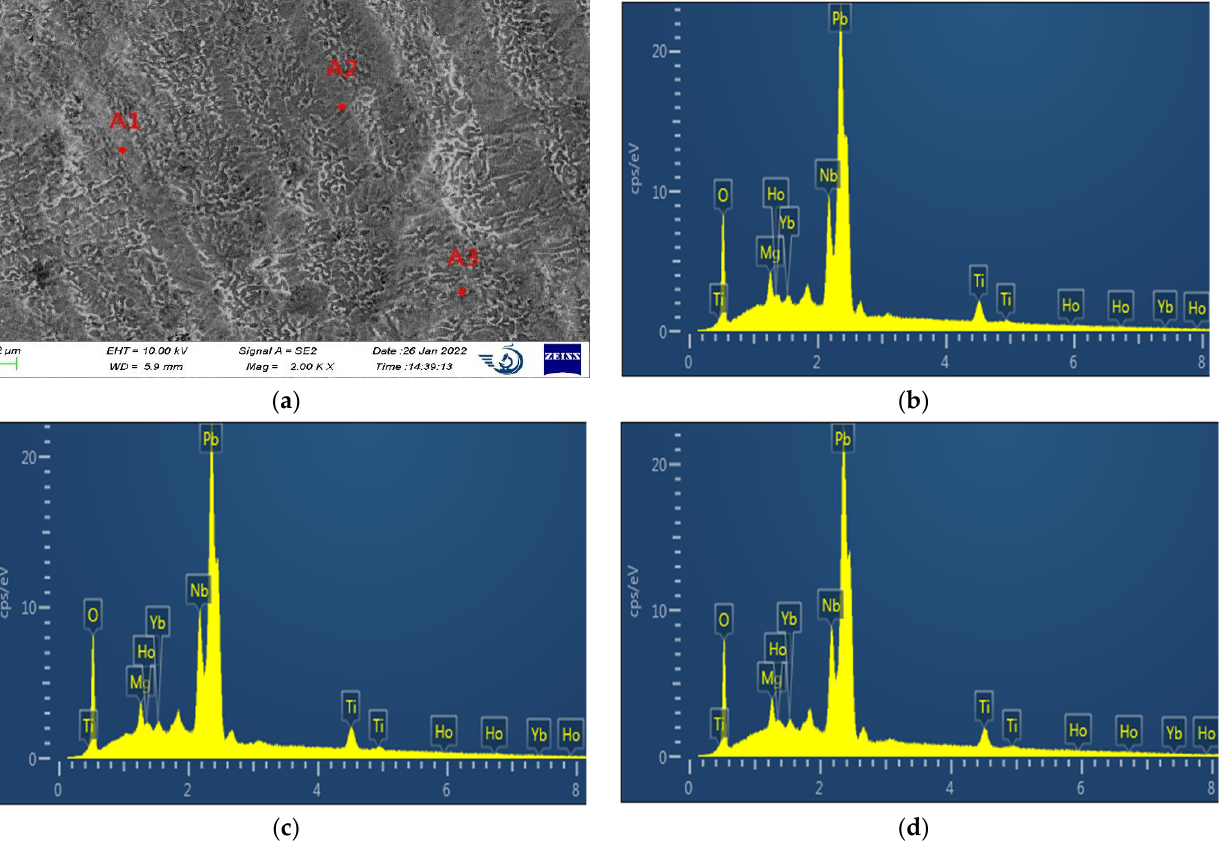
Figure 3. ( a ) energy dispersive system (EDS) of three random points on the surface of PMN- 32PT:Ho 3+ /Yb 3+ crystals. ( b ) EDS spectrum of A1. ( c ) EDS spectrum of A2. ( d ) EDS spectrum of A3. Table 1. The element content of the PMN-32PT: Ho 3+ /Yb 3+ crystals obtained by EDS.